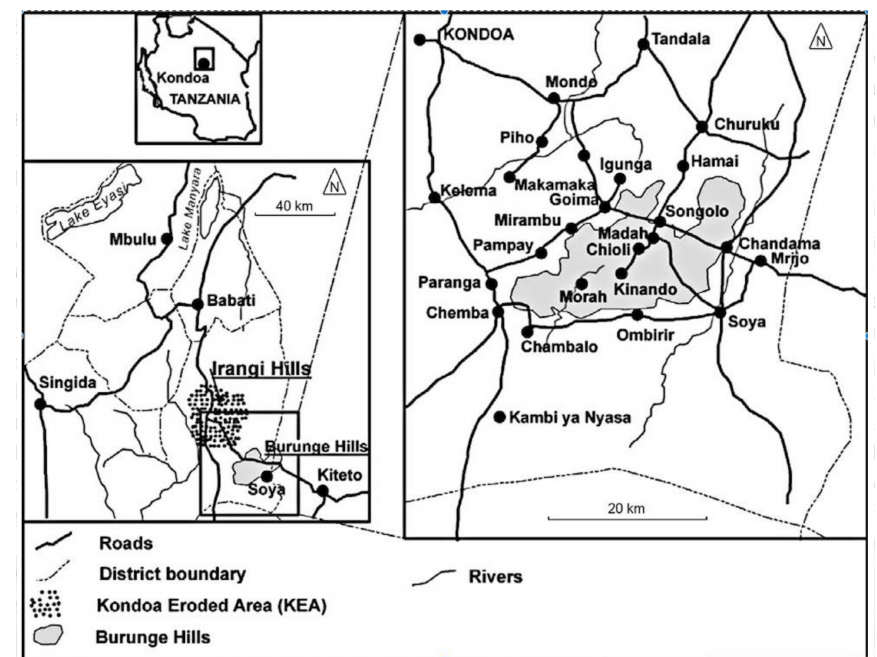
Figure 1. Goima and Mirambu villages on the foot slopes of the Burunge Hills, south-east of Kondoa town, and the Kondoa Eroded Area. Source: Östberg and Slegers